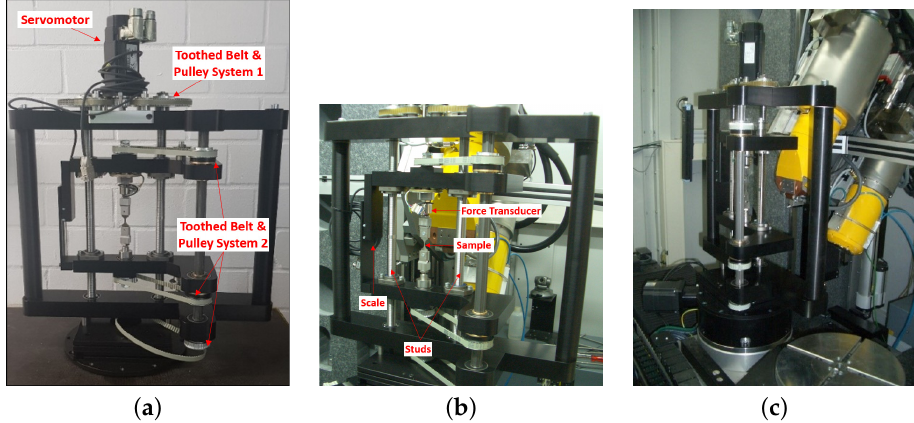
Figure 2. An in-house-designed test rig for in-situ X-ray microscopy (RIF institute, Dortmund, Germany): ( a ) test rig for in-situ X-ray CT; ( b ) inner platform of the test rig; ( c ) test rig installed in X-ray CT machine at the